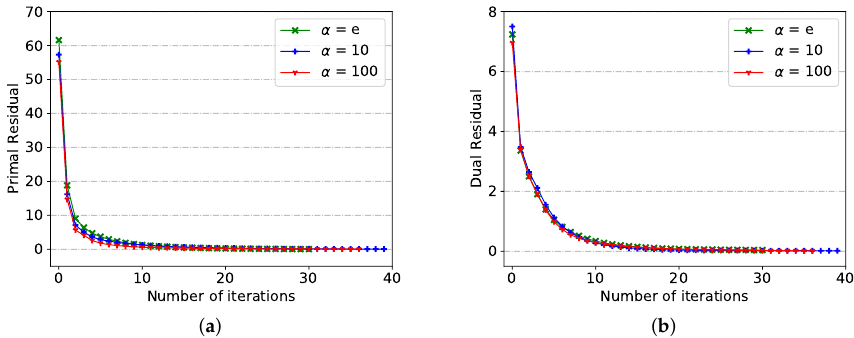
Figure 7. Sensitivity evaluation w.r.t. α : ( a ) primal residual; ( b ) dual residual.